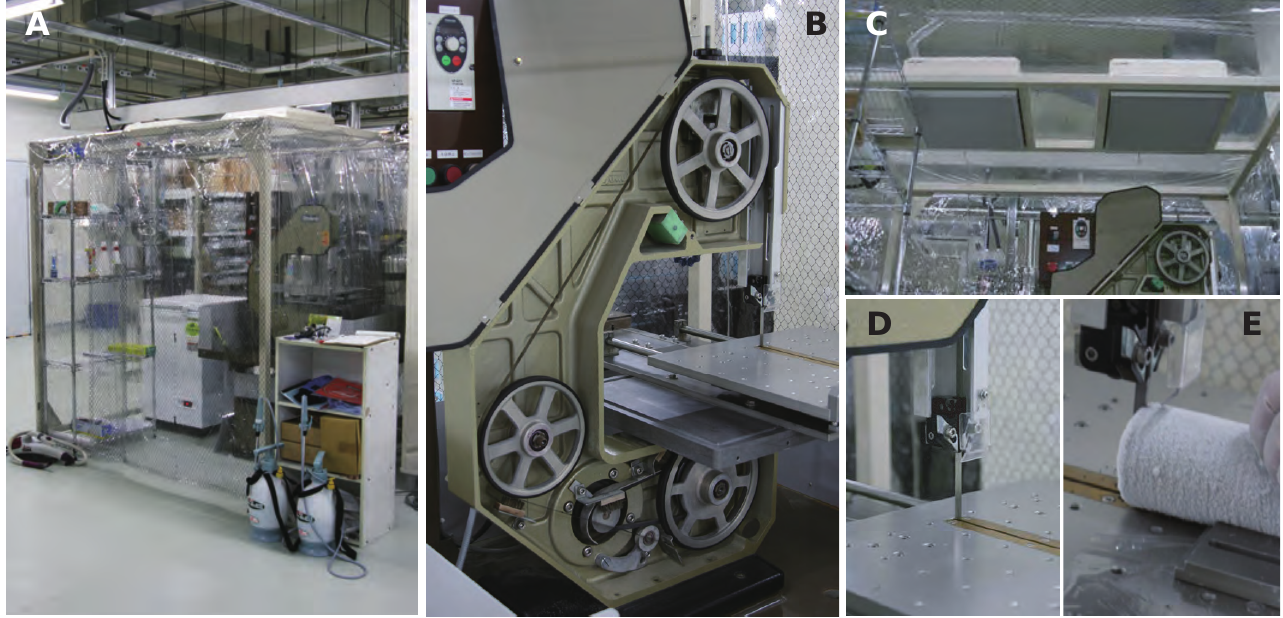
Figure 2 . [A]Overview of the electric band saw system for microbiological frozen core. Motor-driven electric band saw machine [B] and -50 º C freezer is deployed in a clean booth equipped with two HEPA-filter units [C]. Diamond-tipped band saw cuts frozen core samples under clean conditions [D, E].